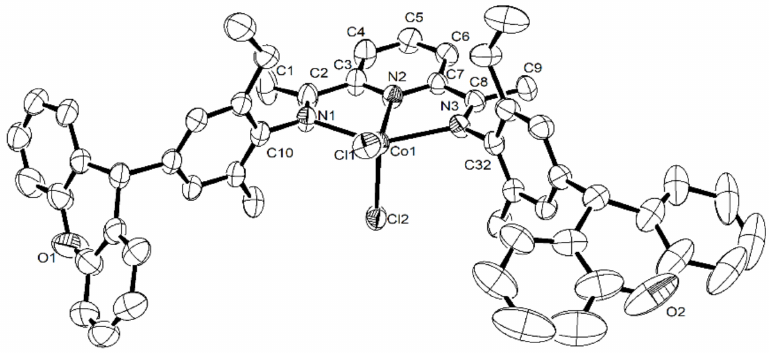
Figure 2. Molecular structure of Co4 with thermal ellipsoids adjusted at the 30% of probability level, and hydrogen atoms are omitted for